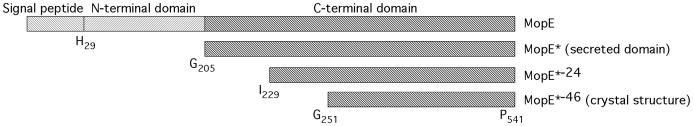
Structural organization of the MopE protein.